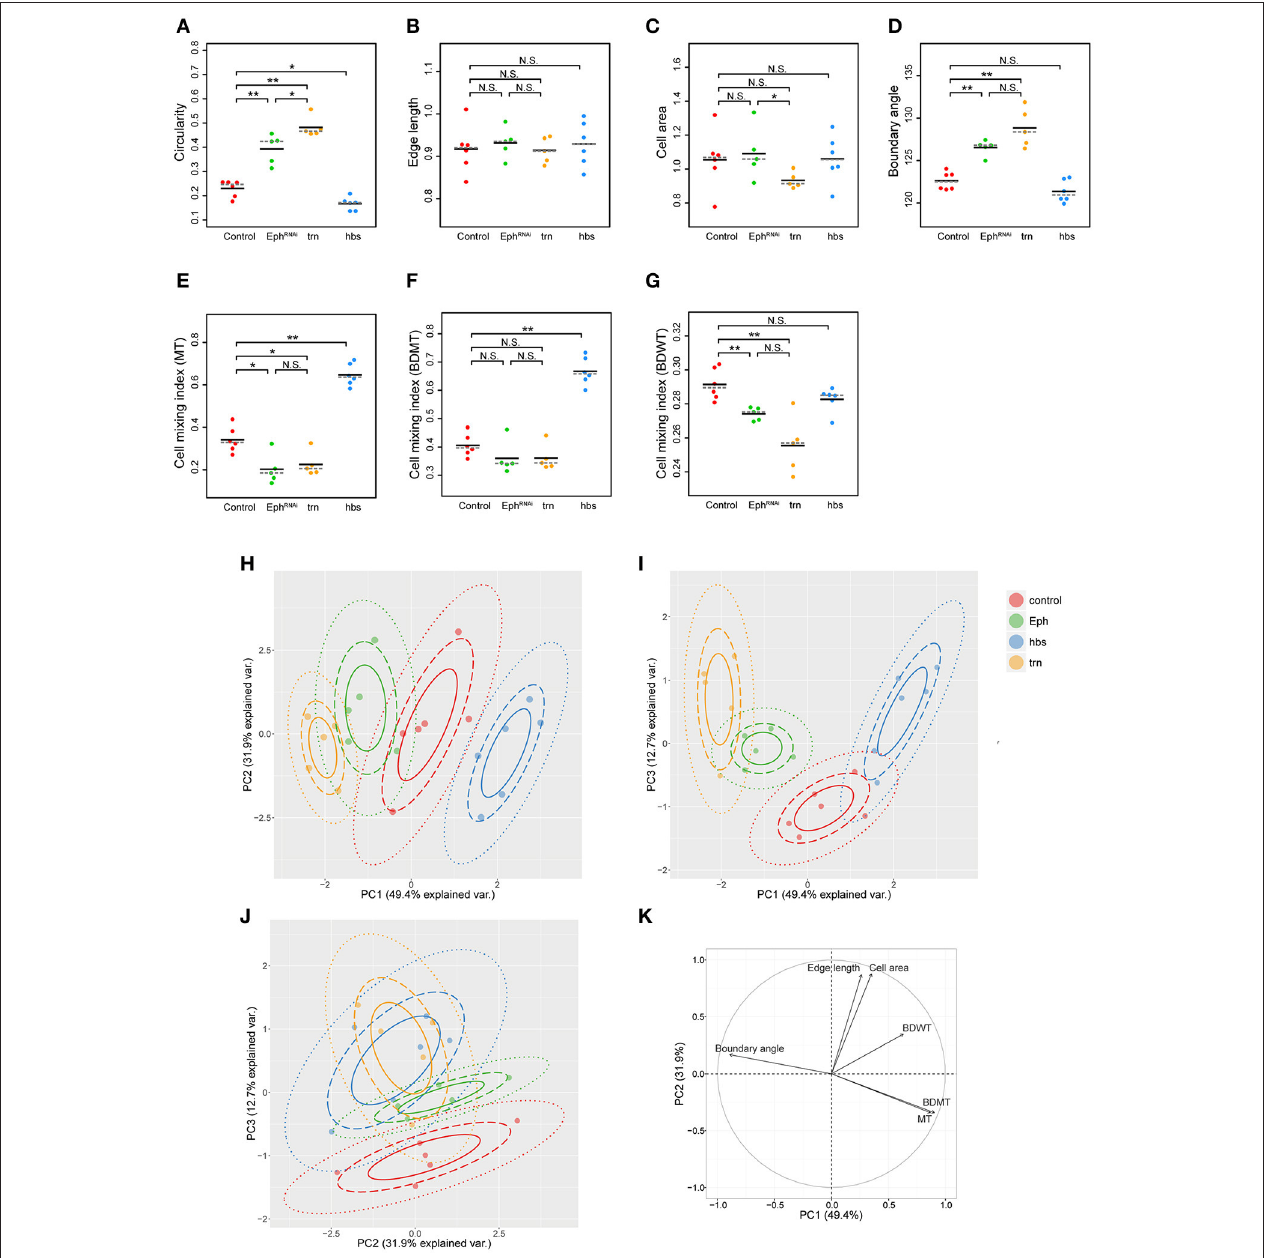
FIGURE 3 | Principal component analysis of clone shape indicators for four genotypes. (A–G) Plots for circularity (A) , edge length (B) , cell area (C) , boundary angle (D) and cell mixing index of MT cells (E) , BDMT cells (F) , and BDWT cells (G) of clones of four genotypes including wild-type (red), Eph RNAi (green), trn overexpression (yellow), and hbs overexpression (blue). The plotted data were obtained from clones with averaging within a disc. Black solid lines and gray broken lines represent the average and median values, respectively. Wilcoxon rank sum test, n 6 for control and hbs overexpression; n 5 for Eph RNAi and trn = = overexpression. ** P < 0.01, * P < 0.05 and P > 0.05 (N.S., Not Significant). (H–J) Results of principal component analysis using six criteria (edge length, cell area, boundary angle, and cell mixing index of MT cells, BDMT cells, and BDWT cells) are plotted for PC1 vs. PC2 (H) , PC1 vs. PC3 (I) , and PC2 vs. PC3 (J) . (K) Quantified contribution (factor loadings; Section Principal Component Analysis (PCA) for definition) of each criterion on PC1 and PC2. The arrow length represents the sum of the squared correlation coefficient of PC1 and PC2, noting that the sum of all PCs is equal to